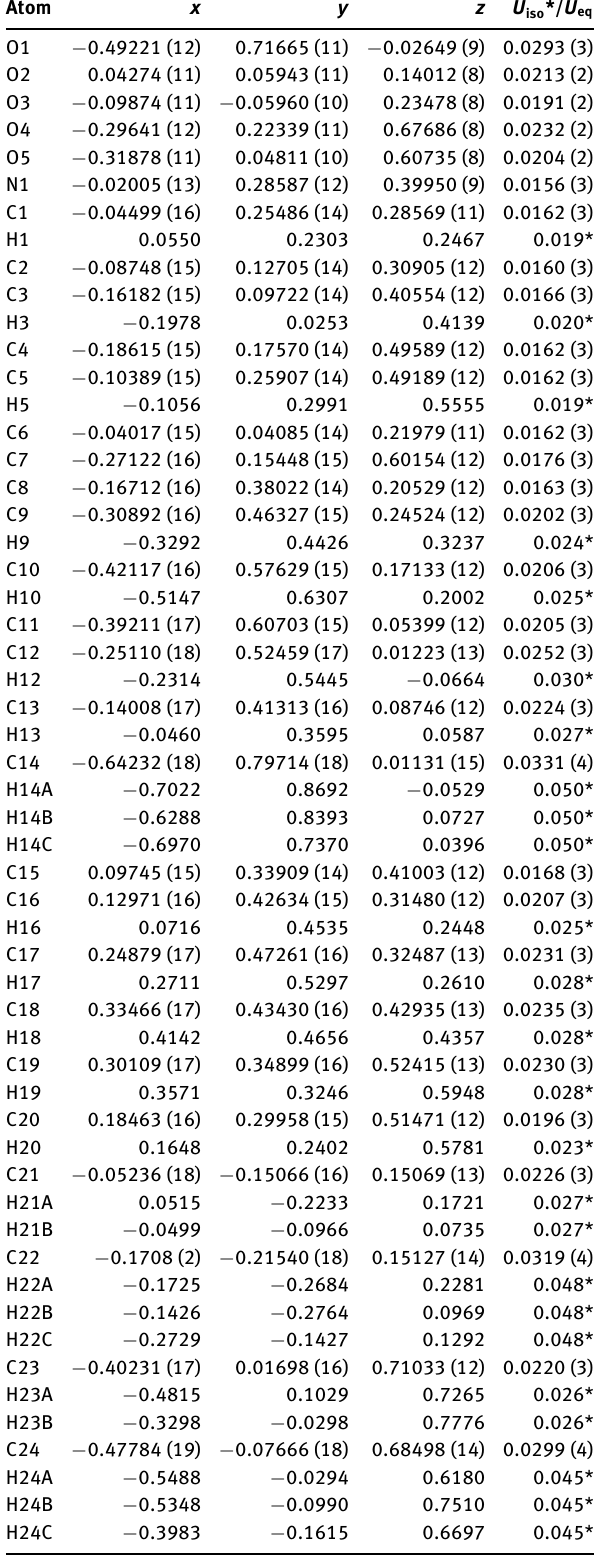
Table 2: Fractional atomic coordinates and isotropic or equivalent isotropic displacement parameters (Å 2